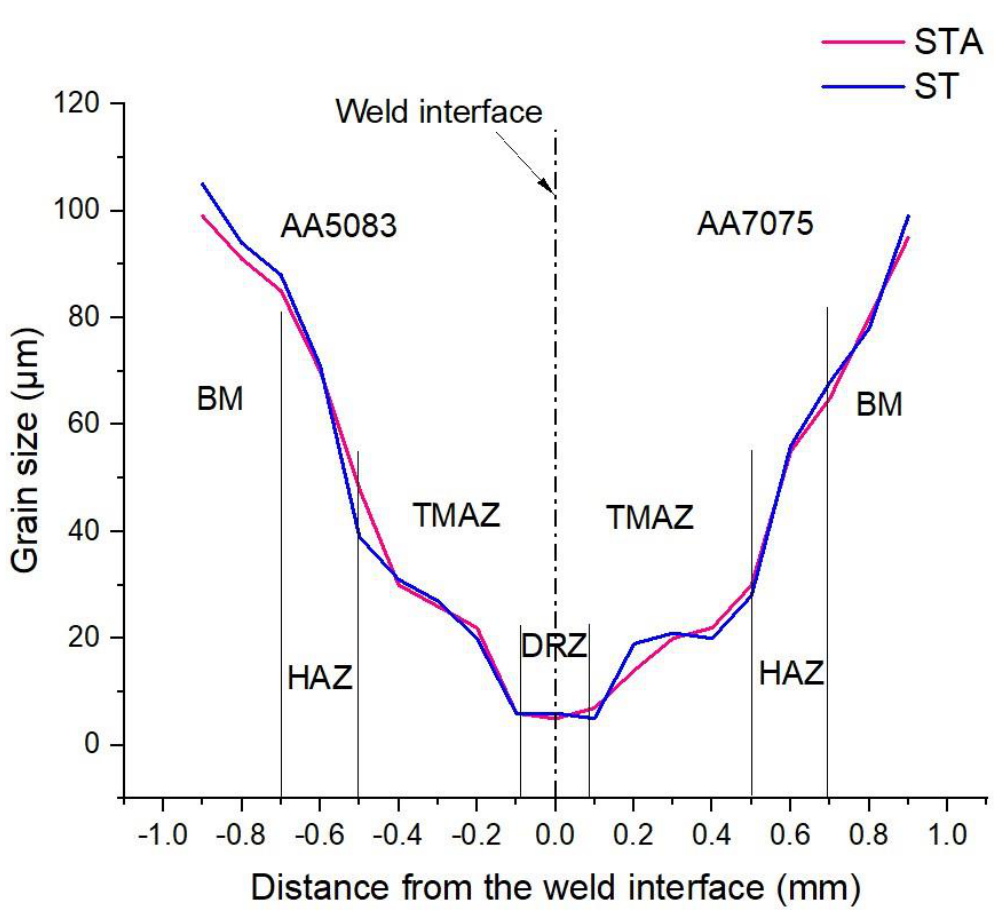
Figure 10. Average grain size variation across different weld zones of AA5083/AA7075 welds.